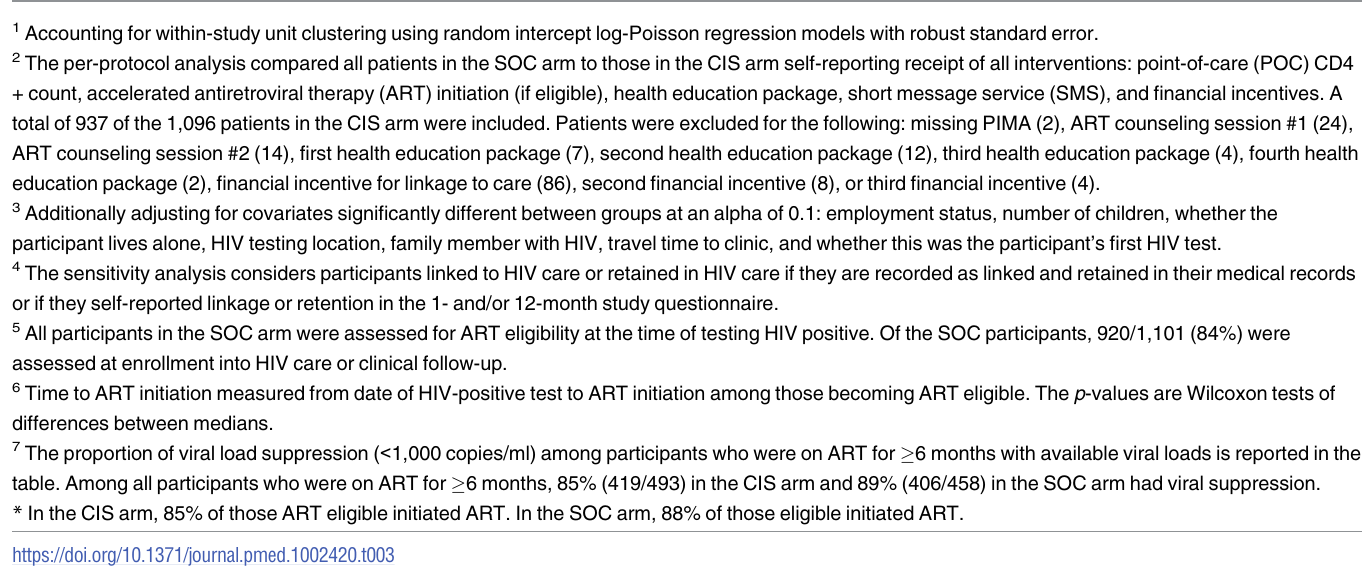
table. Among all participants who were on ART for (cid:21) 6 months, 85% (419/493) in the CIS arm and 89% (406/458) in the SOC arm had viral suppression. * In the CIS arm, 85% of those ART eligible initiated ART. In the SOC arm, 88% of those eligible initiated ART.